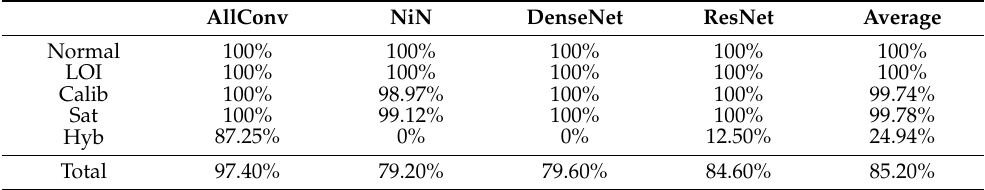
Table 6. The probability of being attacked under non-target attack (3 pixel). AllConv: all convolution network. NiN: Network in Network. Normal: the unattacked state. LOI: LO intensity attacks. Calib: calibration attacks. Sat: saturation attacks. Hyb: the hybrids attacks. AllConv NiN DenseNet ResNet Average